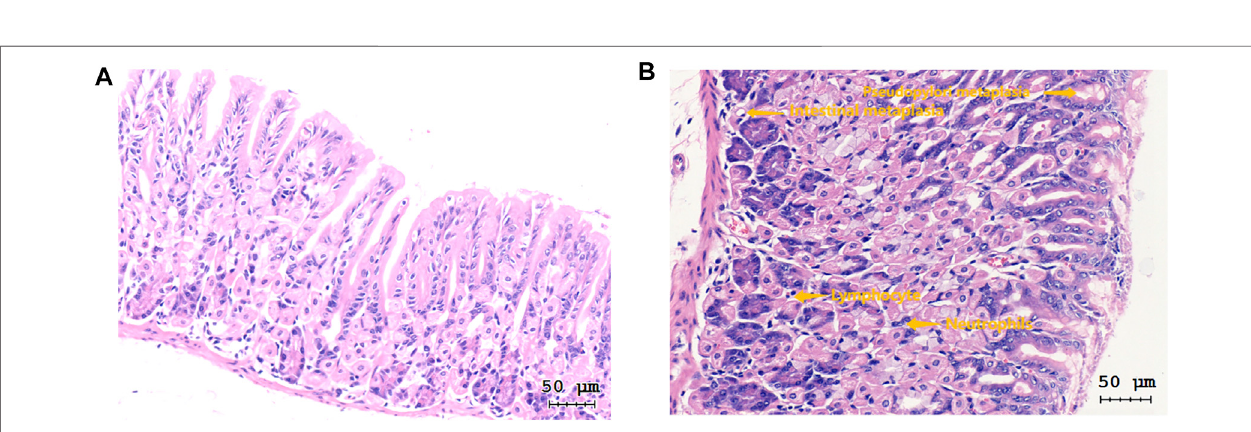
FIGURE3| ImagesofHE stainingofgastric tissue sections (magni fi cation = ×200). (A) Representative image ofHE staining ofgastric tissue sections in thecontrol group; (B) Representative image of HE staining of gastric tissue sections in the experiment group.